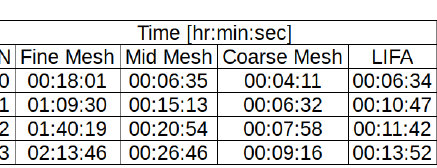
Table 3: 2D/1D Runtimes Table 4: 2D/1D Memory